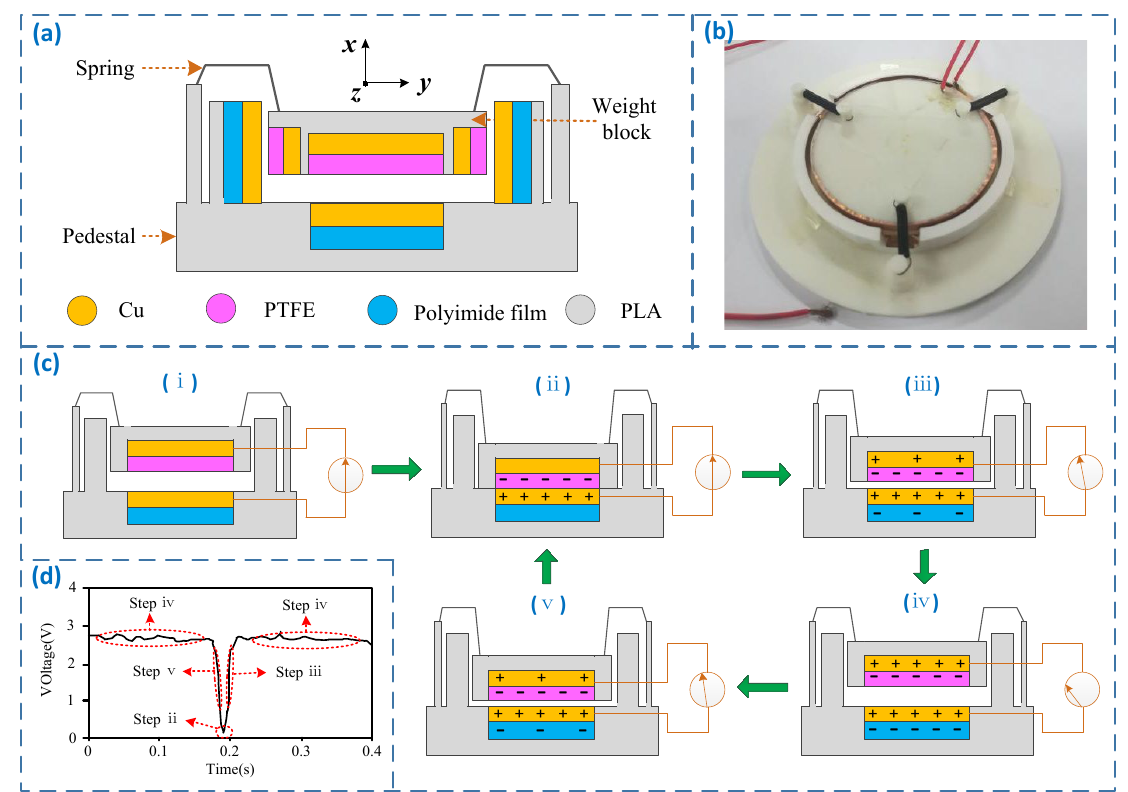
Figure 2. Composition and working principle of the vibration sensor. ( a ) Composition of the vibration sensor; ( b ) picture of the vibration sensor; ( c ) working steps of the vibration sensor when measuring axial vibration, and c–i to c–v are the schematic diagrams of various states in the working process; and ( d ) theoretical output voltage signal when measuring axial vibration.